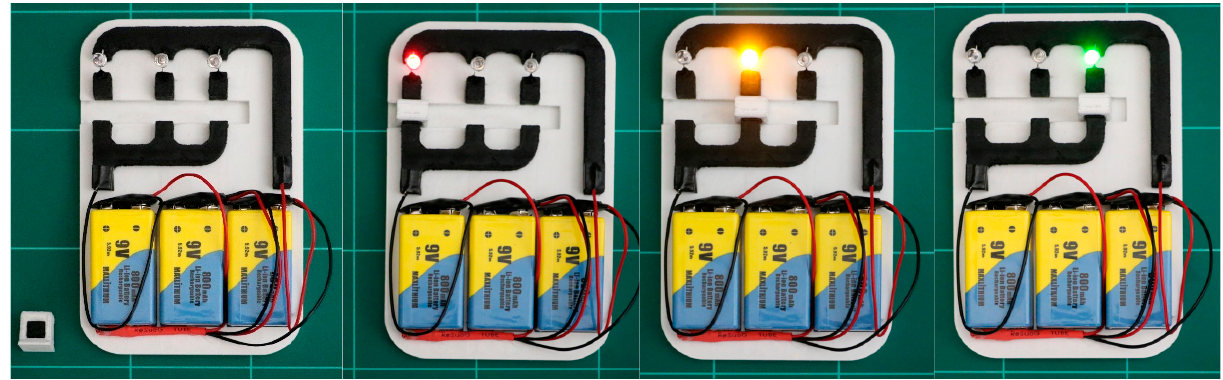
Figure 8. Three-dimensional printed electronic prototype with conductive (around 5 wt.% MWCNT) and non-conductive PLA-based filament. and non-conductive PLA-based